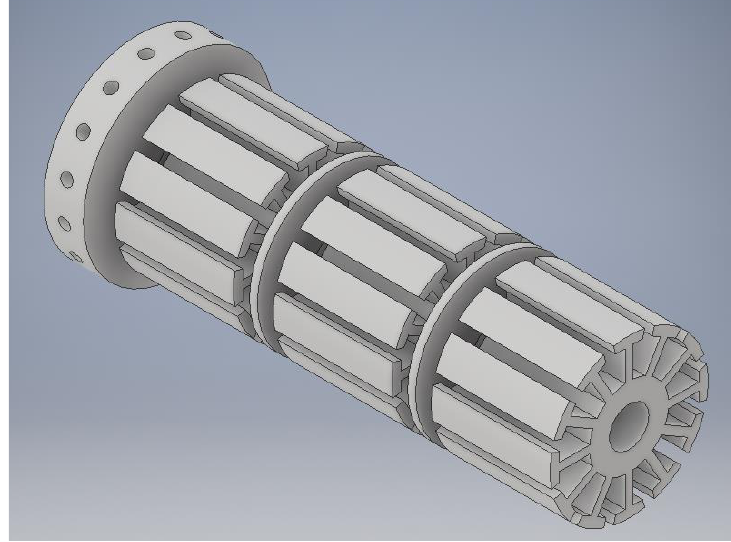
Figure 4. Multilayer stator construction of the BLDC motor .